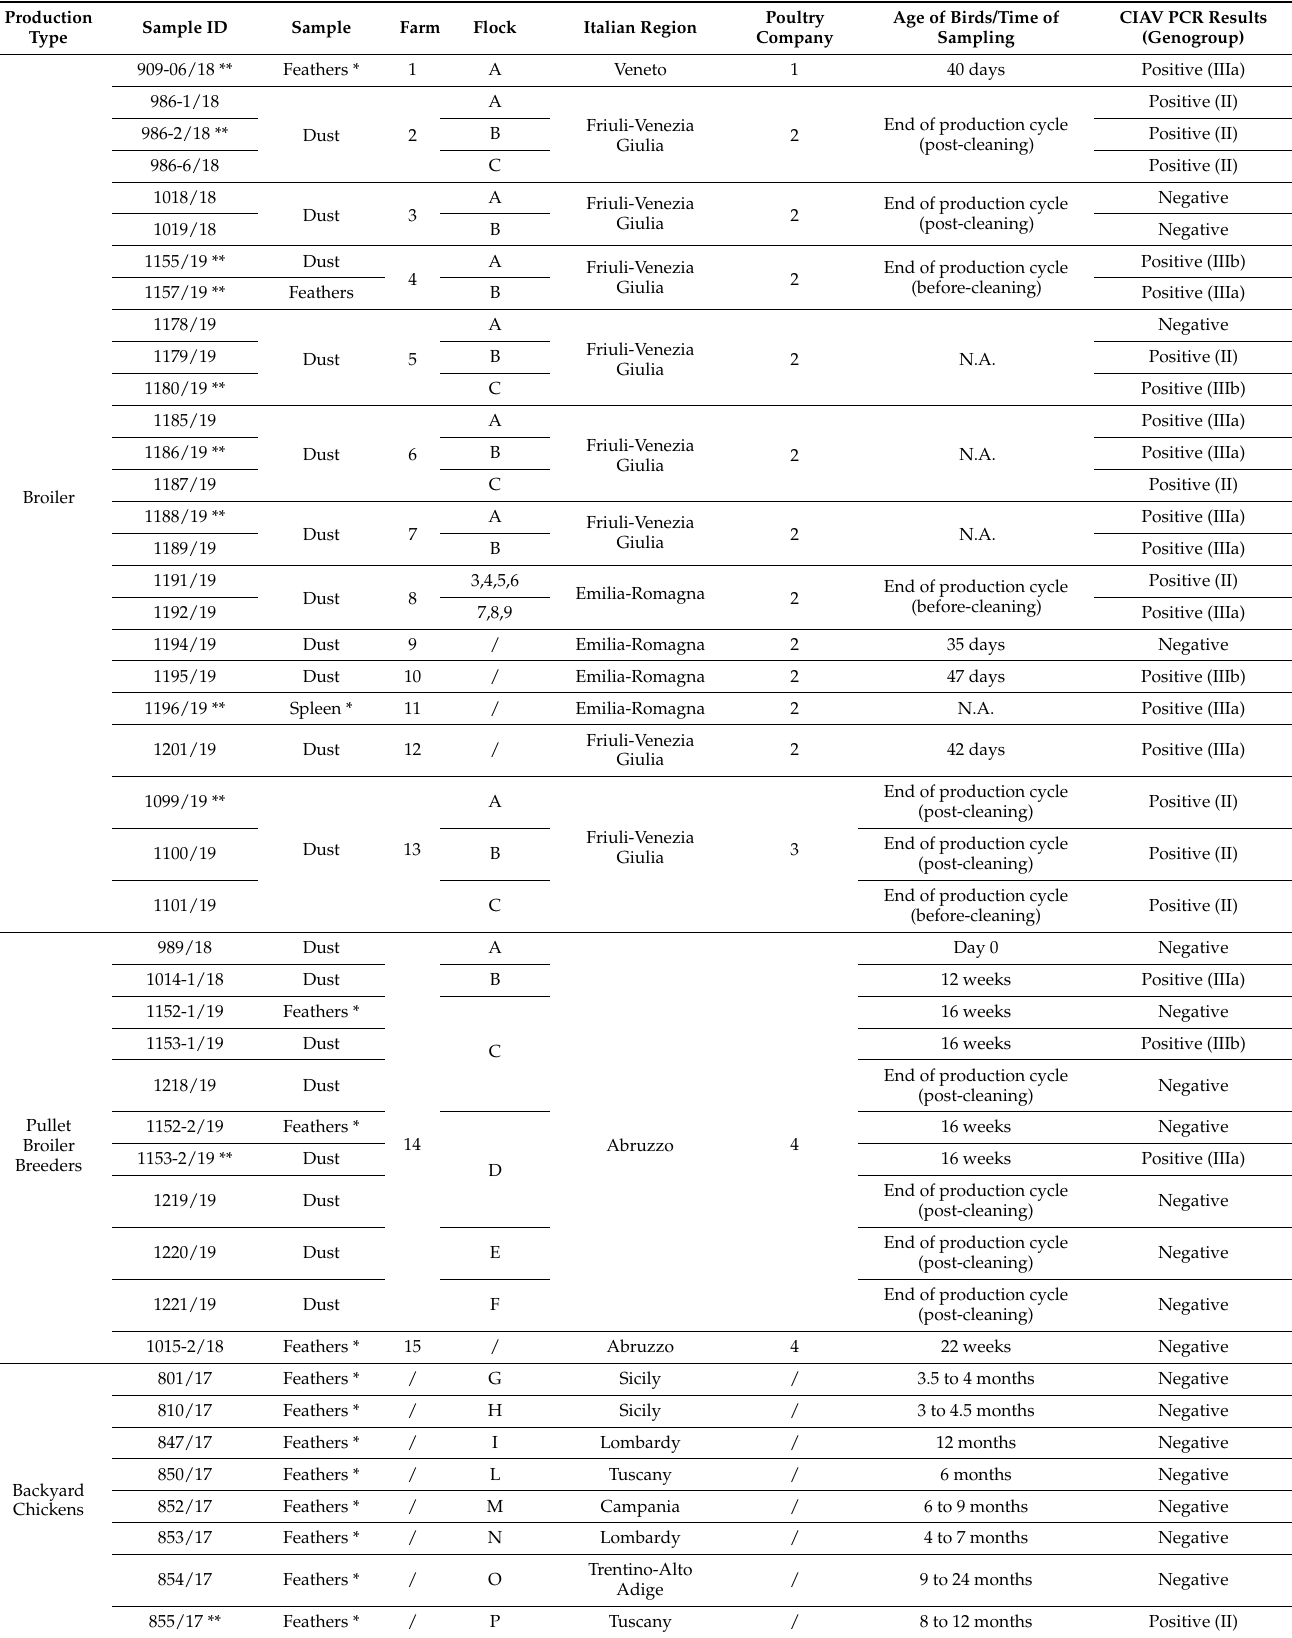
Table 1. Details of the samples collected and results of chicken infectious anemia virus (CIAV) detection and genogrouping. Production